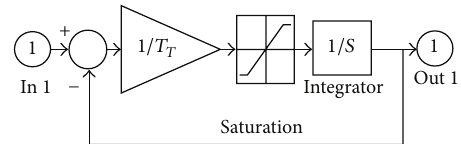
Figure 3: Nonlinear turbine model with GRC.